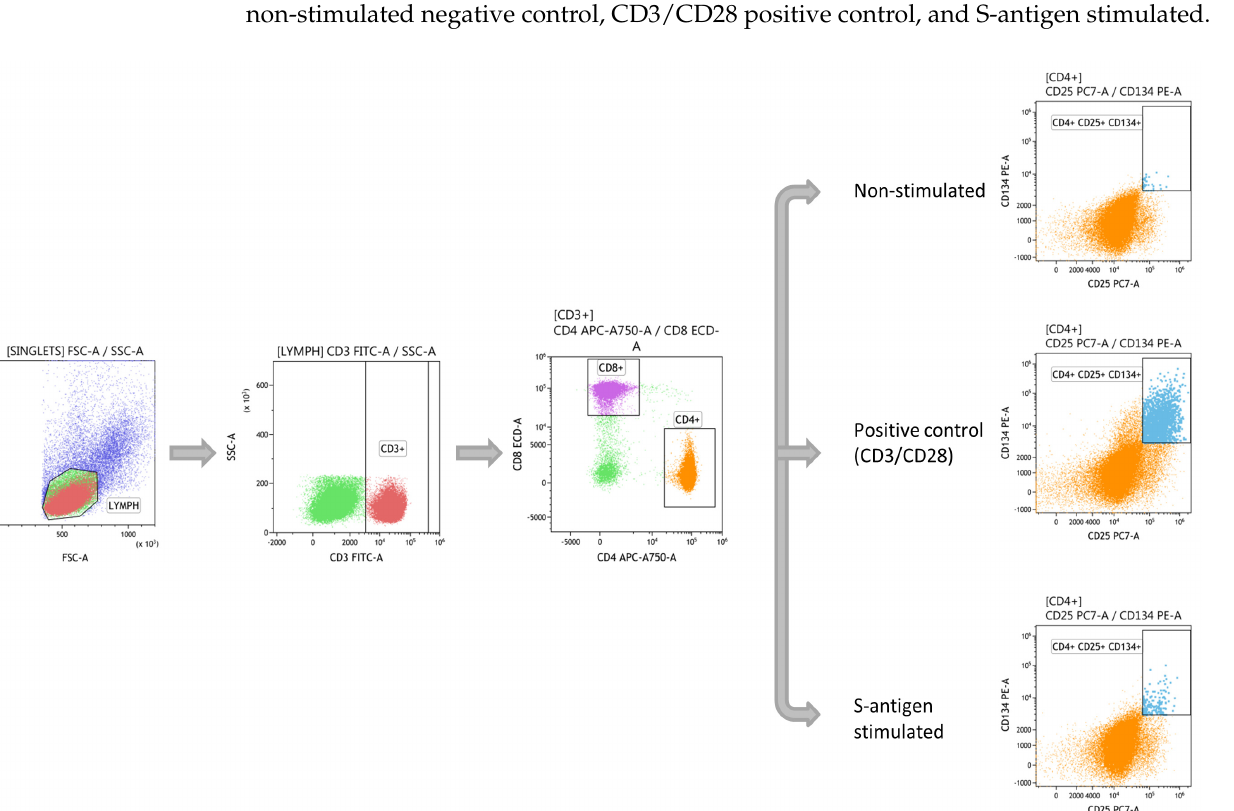
Figure 2. Gating strategy of the T-specific response against S-antigen of SARS-CoV-2 as explained in the text.